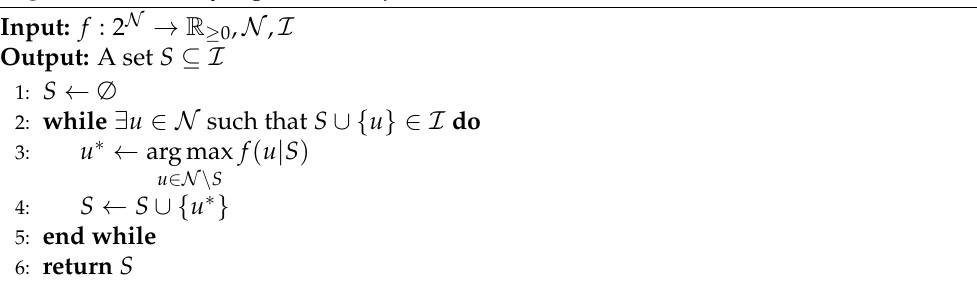
Algorithm 1 Greedy algorithm subject to matroid